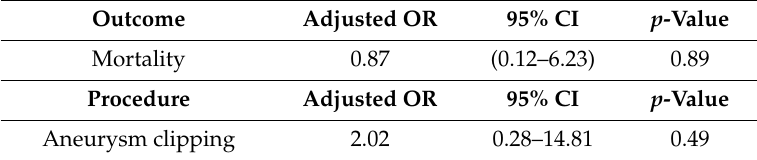
Table 2. Outcomes and procedures of ADPKD and non-ADPKD patients with SAH.